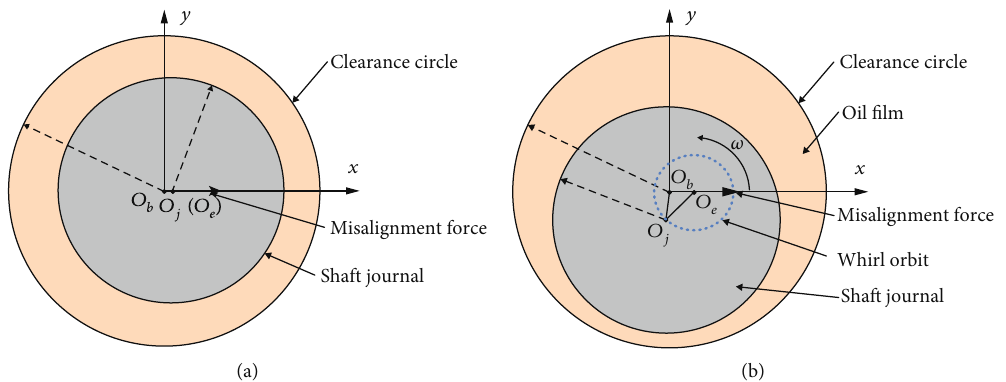
Figure 3: The SFD of the rotor system with static eccentricity. (a) In the static state. (b) In the working